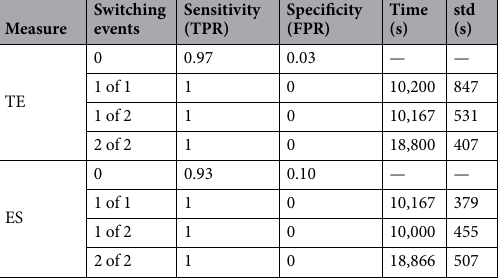
Table 1. Performance of the method and estimated leadership switching time in the Vicsek model.